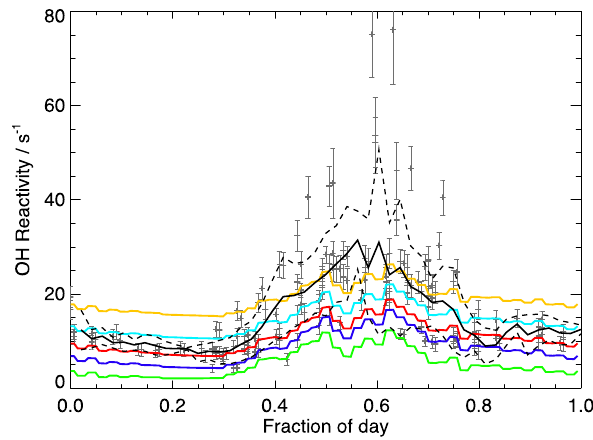
Figure 13: Diurnal variation of the observed OH reactivity (black points) and a set of model simulations with different first order loss rates to represent the loss of model generated Fig. 13. Diurnal variation of the observed OH reactivity (black species to physical processes. The lifetime of species with respect to this first order loss are points) and a set of model simulations with different first-order loss 1 (green), 12 (dark blue), 24 (red) 48 (pale blue), and 96 (yellow) h. rates to represent the loss of model generated species to physical The value of this physical loss parameter is difficult to determine experimentally, and our processes. The lifetime of species with respect to this first-order treatment of this process, via a uniform loss rate for all compounds, is simplistic. However, it loss are 1 (green), 12 (dark blue), 24 (red), 48 (pale blue), and 96h does point towards the large sensitivity of modelled OH reactivity towards this parameter. More complex representations of canopy mixing (such as that used by Wolfe and Thornton 2011) may be one approach to better constrain this parameter. Uptake to aerosols and the deposition of species to the forest soils and canopy through wet and dry processes is complex and poorly understood. It is thought that wet deposition is a major loss route for these oxygenated VOCs (OVOCs), due to their high solubility [Hall et al. 1999; Reeves and Penkett, 2003; Matsunaga et al., 2007]. However, the solubility of many hydroperoxides and other oxygenated organics is extremely uncertain and known to cover a wide range, with the measured Henry’s law constants for methyl hydroperoxide and peroxyacetic acid being 2–3 orders of magnitude lower than that for H 2 O 2 [Lind and Kok, 1986]. Observations of OVOC deposition velocities are sparse, with only a handful reported for forested regions [Hall and Claiborn, 1997; Valverde Canossa et al., 2006; Hall et al., 1999; Karl et al., 2004; Kuhn et al., 2002]. An observation of the deposition velocity of the sum of MVK and MACR in a